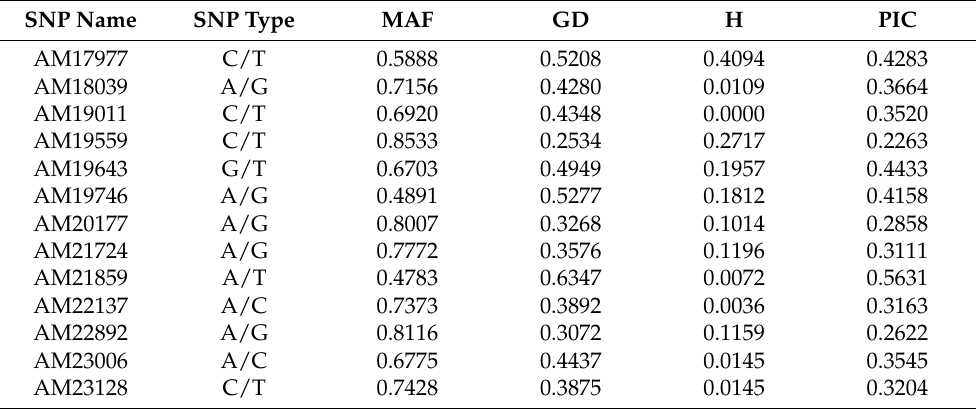
Table 1. Genetic diversity for 44 SNP markers evaluated for 276 Amaranthus